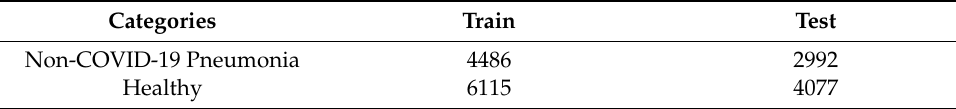
Table 2. Dataset Split for non-COVID-19 CXR Model (60:40 Ratio).